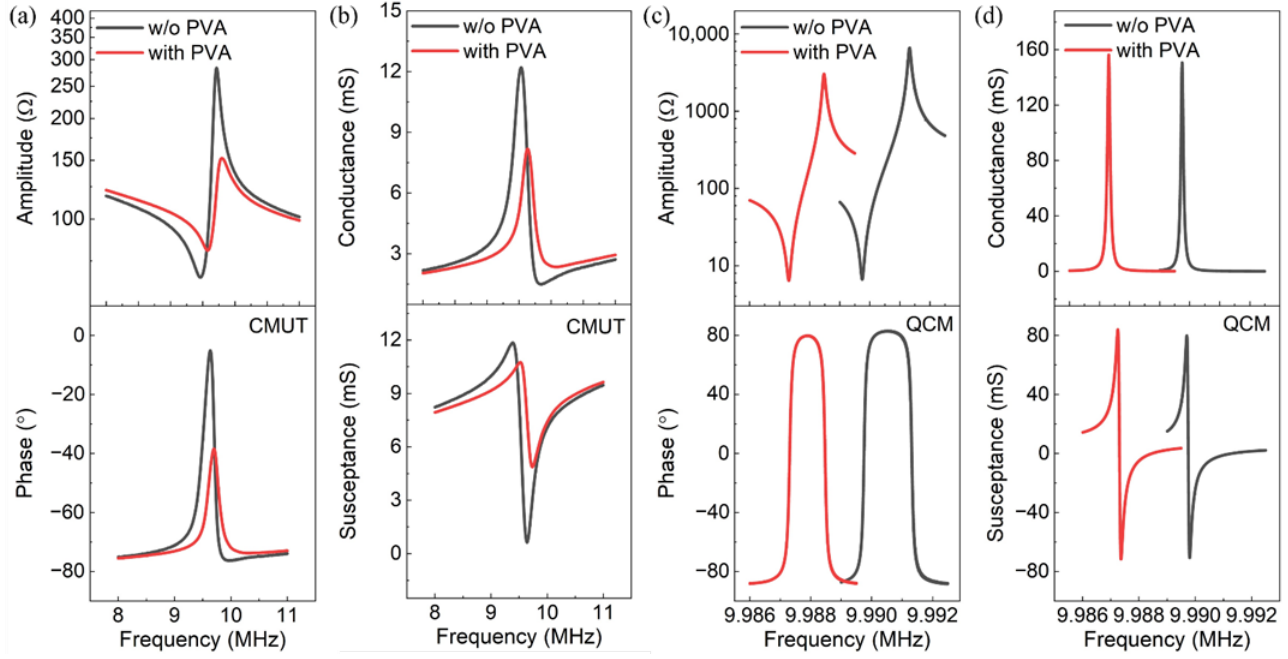
Figure 4. Electrical characterizations of the CMUT: ( a ) impedance and ( b ) admittance; electrical characterizations of the QCM: ( c ) impedance and ( d ) admittance.